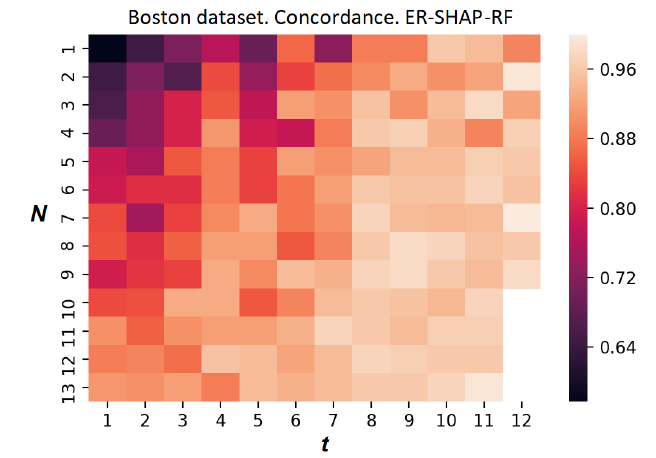
Figure 20. The heatmap reflecting the concordance index C obtained by ER-SHAP-RF for the Boston Housing dataset without using the temperature